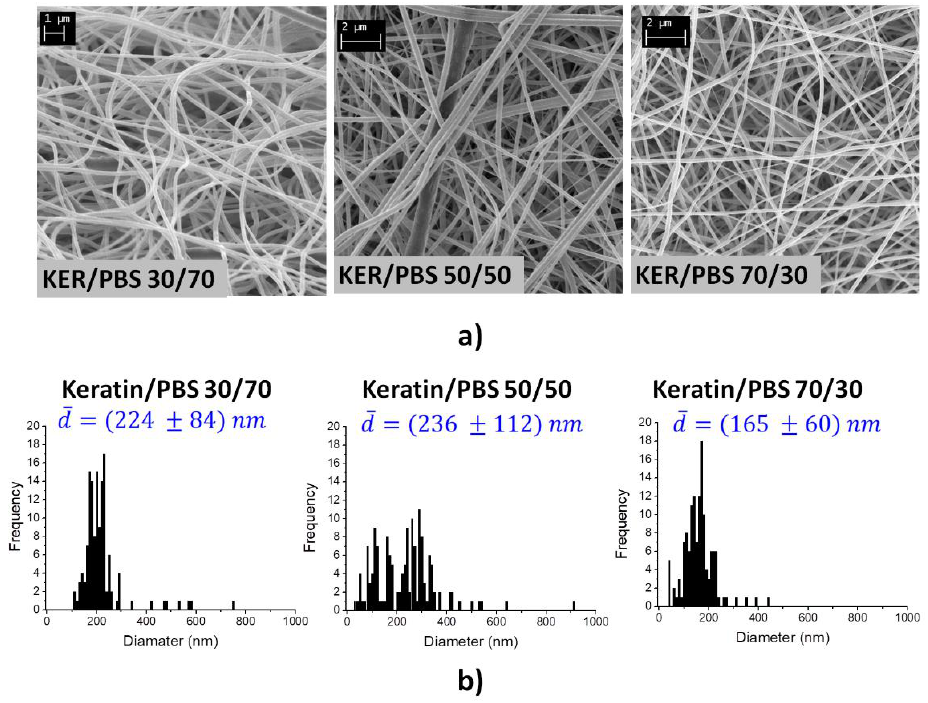
Figure 3. ( a ) SEM images and ( b ) Diameter distribution and mean diameter ( 𝑑̅ ) of keratin/PBS 30/70, 50/50 and 70/30 blend nanofibers.